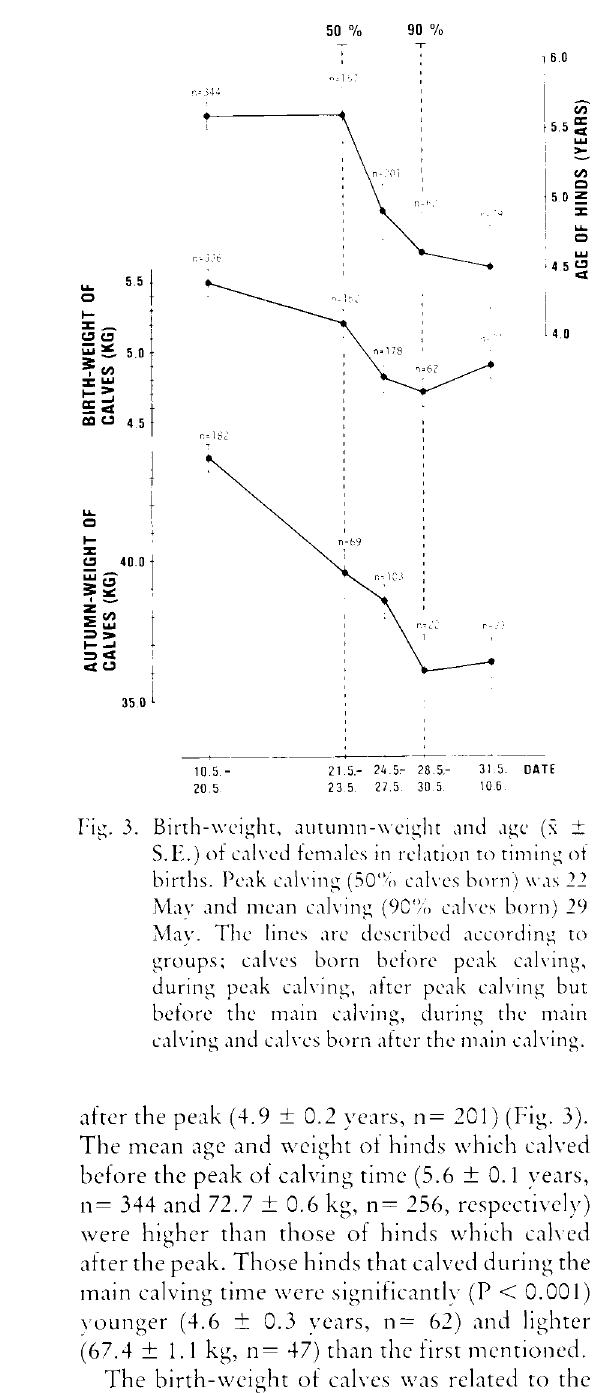
Fig. 4. The relationship between birth-weight and autumn-weight of calves. The line